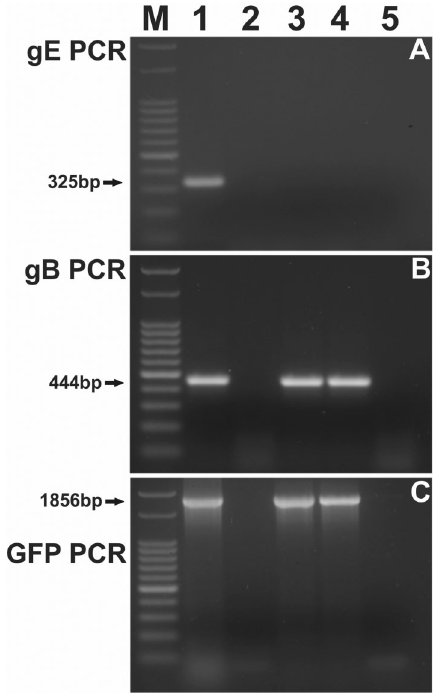
Figure 3. Con fi rmation of the gE gene deletion in the recombinant BoHV-1 Δ gE by PCR. A , PCR of the gE gene. B , PCR of the gB gene. C , PCR of the GFP marker gene. Lane M , molecular weight marker; lane 1 , parental virus (SV56/90) ( A,B ) or pEGFP-C1 plasmid ( C ); lane 2 , DNA sample from non-infected MDBK cells - negative DNA control; lane 3 , BoHV-1 Δ gE #2; lane 4 , BoHV-1 Δ gE #3; lane 5 , negative control